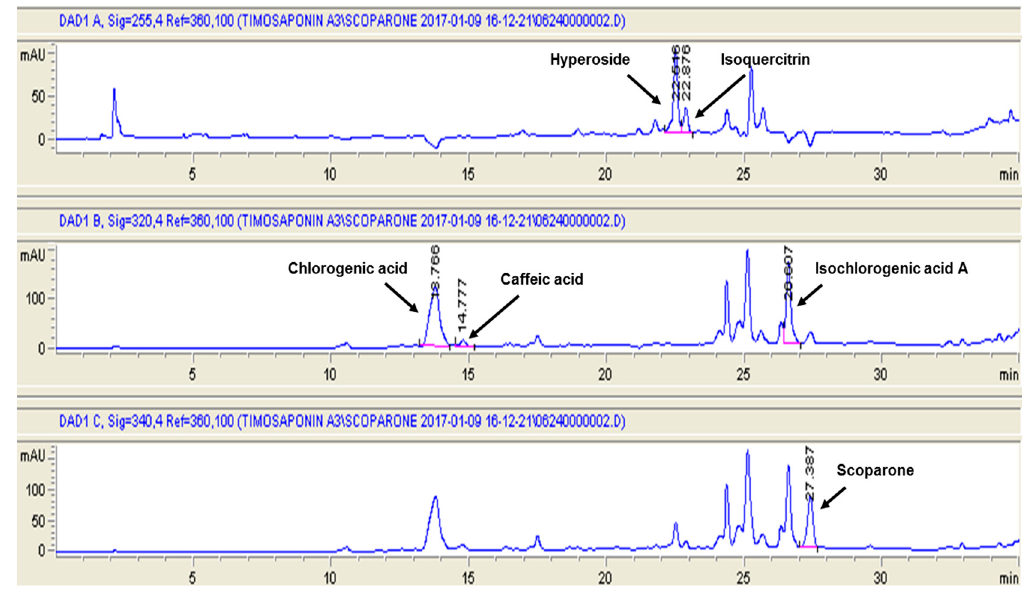
Figure 2. High performance liquid chromatography (HPLC) chromatograms of ethanol extract of Artemisia capillaris . The detection wavelength was set at 255 nm for hyperoside and isoquercitrin, at 320 nm for chlorogenic acid, caffeic acid, and isochlorogenic acid, and at 340 nm for scoparone. Table 1. The content of six marker compounds of hydroethanolic extract of A. capillaris . ( n = 3).